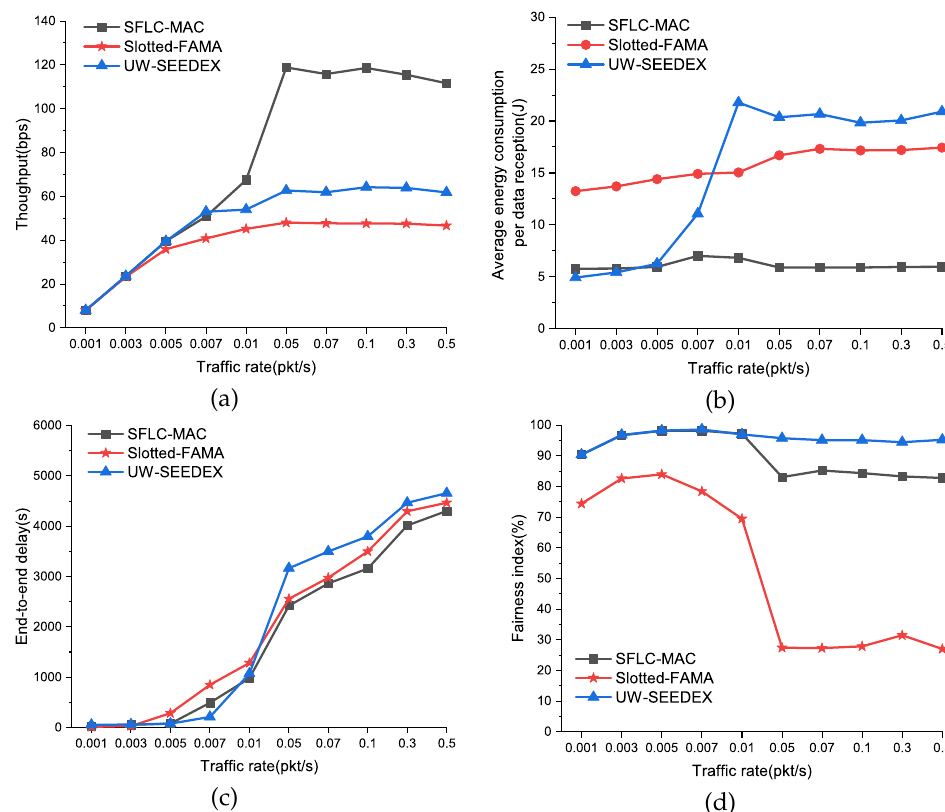
Figure 13. The performance of SFLC–MAC, UW–SEEDEX and Slotted–FAMA in relation to the traffic rate. ( a ) The throughput. ( b ) The average energy consumption per data reception. ( c ) The end–to–end delay. ( d ) The fairness